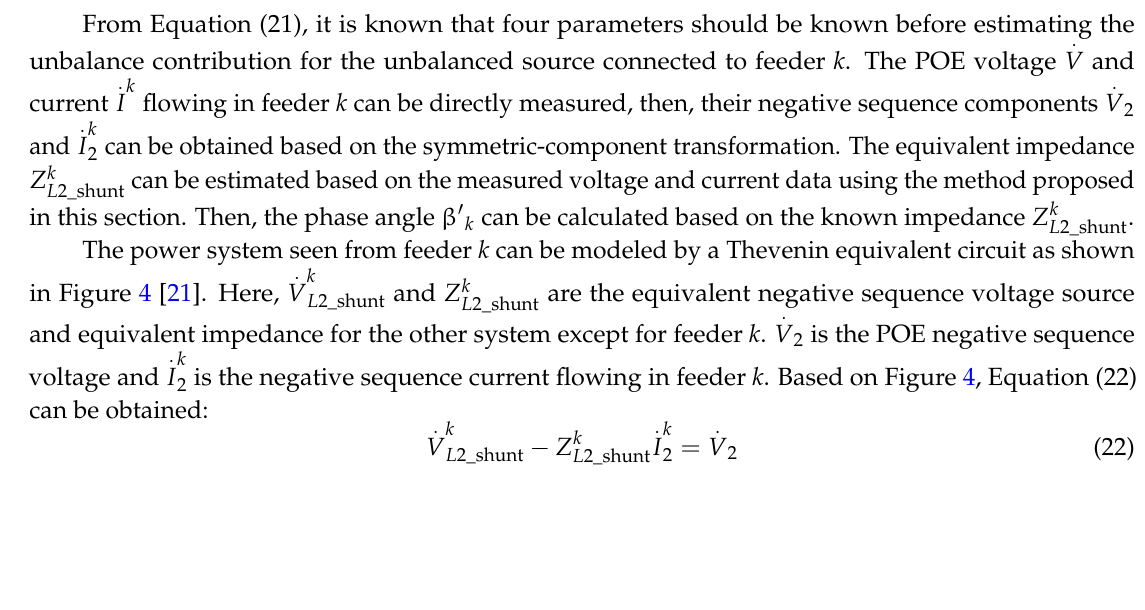
Figure 4. Negative sequence equivalent circuit viewed from feeder k . The POE voltage  2 V and feeder k current  k I